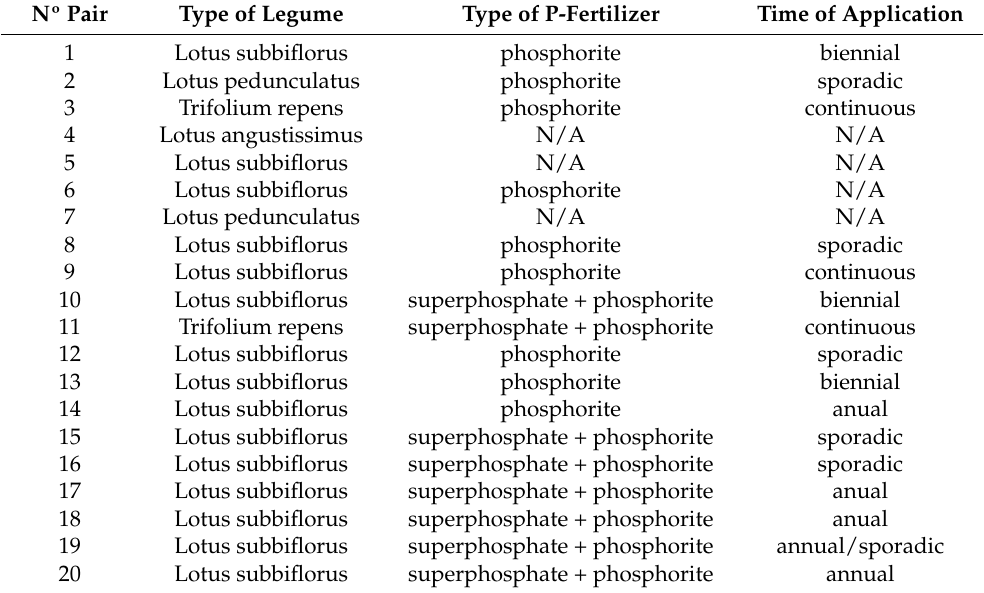
Table A1. Technological information of intensification practice of each